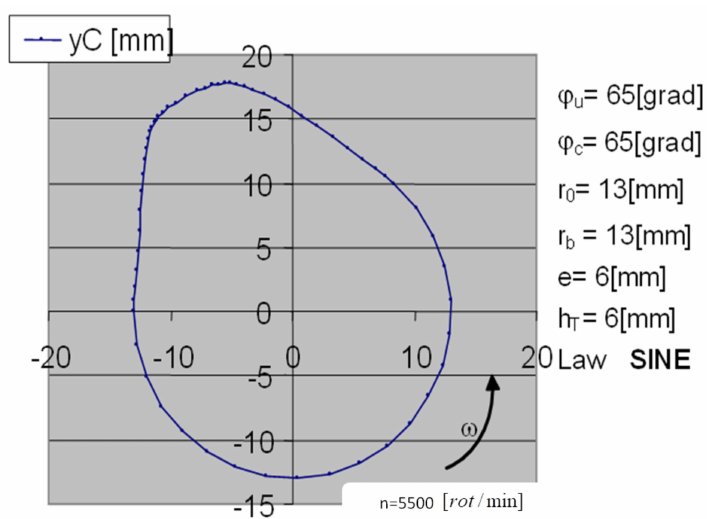
Figure 13. Cam profile at module B. SINE law, n = 5500 [rot/min] ϕ u = 65 [degree], r 0 = 13 [mm], r b = 13 [mm], h T = 6 [mm].